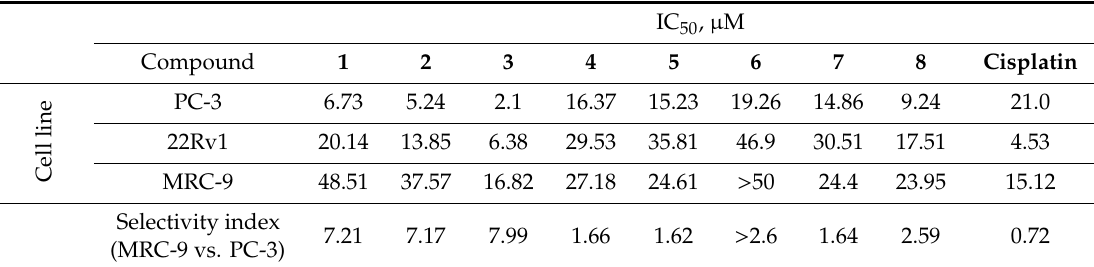
Table 4. Inhibition concentrations 50% (IC 50 s) of the investigated compounds in di ff erent cell lines. The cells were treated for 48 h. Cisplatin was used as a positive control. Selectivity index (SI) was calculated as [IC 50 in MRC-9 cells] / [IC 50 in PC-3 cells].